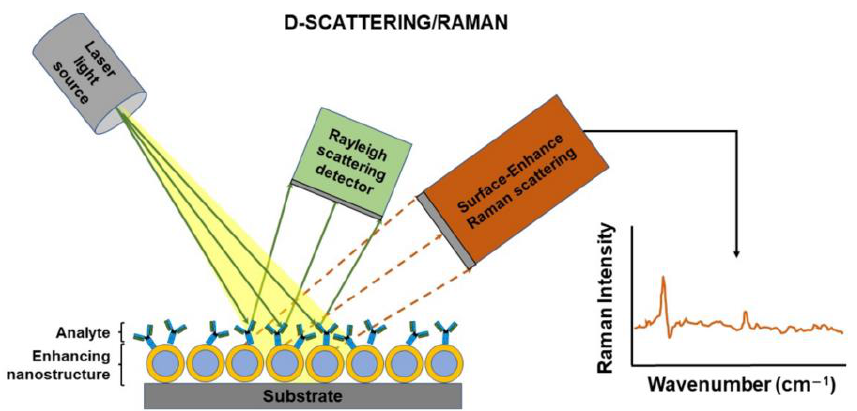
Figure 13. Schematic diagram of Raman spectroscopy (SERS).